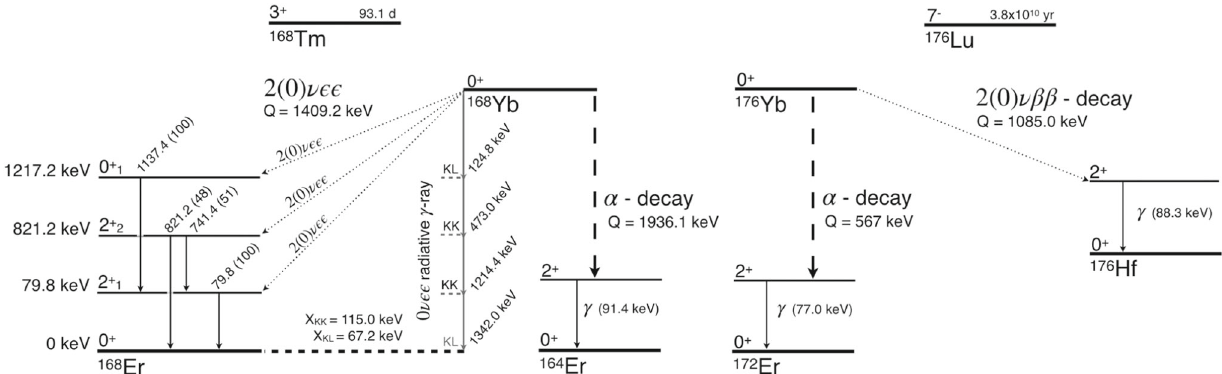
two electron captures, sharing the available energy with a combination of X KK or X KL . Angular momentum conservation does not allow the KK capture combination for decays into 0 + states. Data taken from [39]